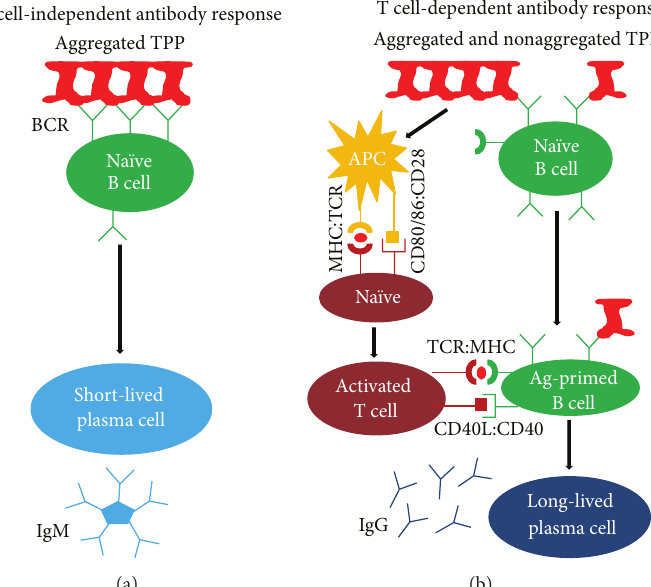
Figure 1: Schematic overview of aggregate-induced T cell-independent and T cell-dependent antibody responses. (a) In the T cell- independent pathway aggregates of TPP cross-link BCRs and activate B cells, which differentiate into short-lived plasma cells that generate antigen-specific IgM pentamers. (b) In the T cell-dependent pathway both aggregated and nonaggregated TPP can be captured by B cells or by APC which present TPP-derived epitopes to activate T cells, which in turn activate antigen-primed B cells. The activated B cells differentiate into long-lived plasma cells that generate isotype-switched